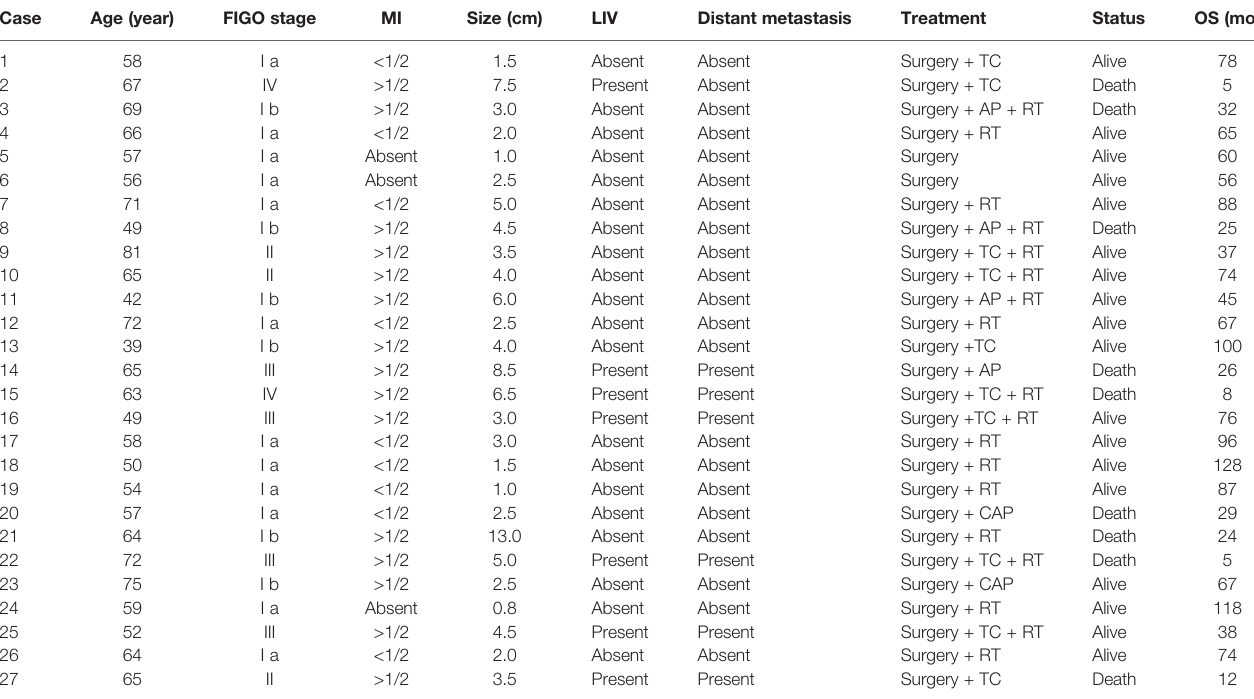
TABLE 1 | Clinicopathological characteristics in the 27 Patients included in this